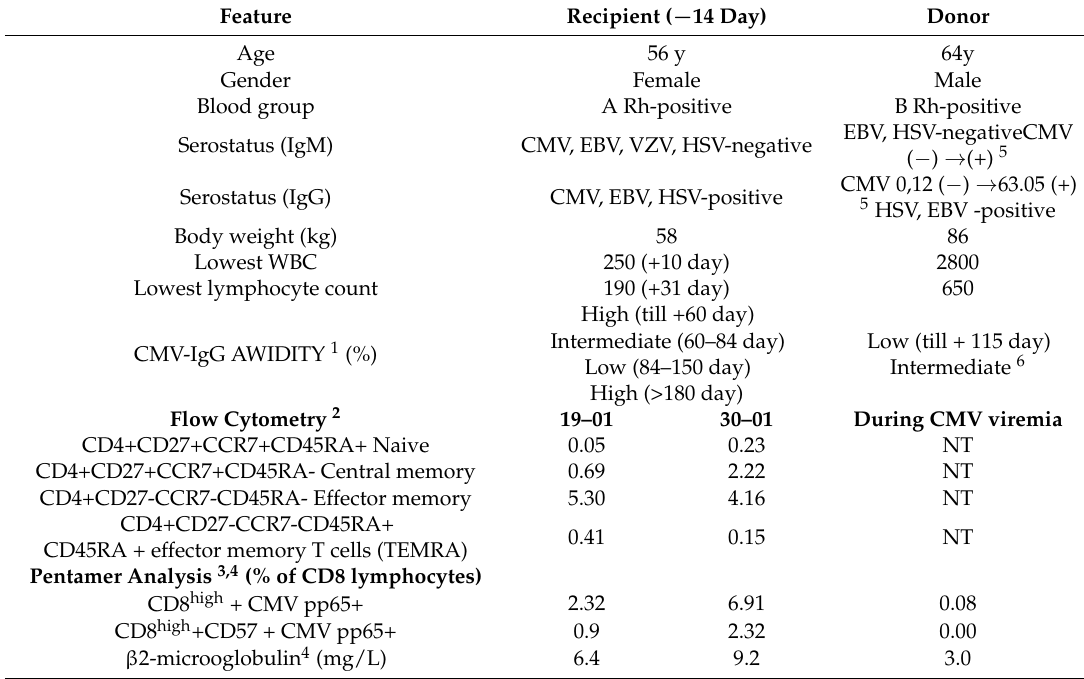
Table 1. Recipient and donor demographic data and crucial